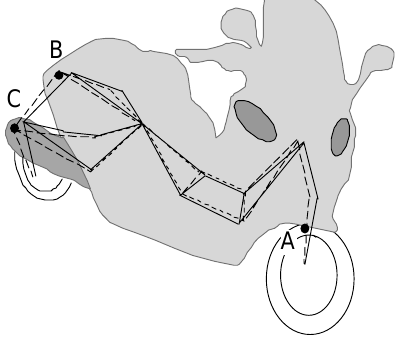
Fig. 15. Vehicle B, structural mode, frequency 24.7 Hz, hysteretic damping 2.9%.